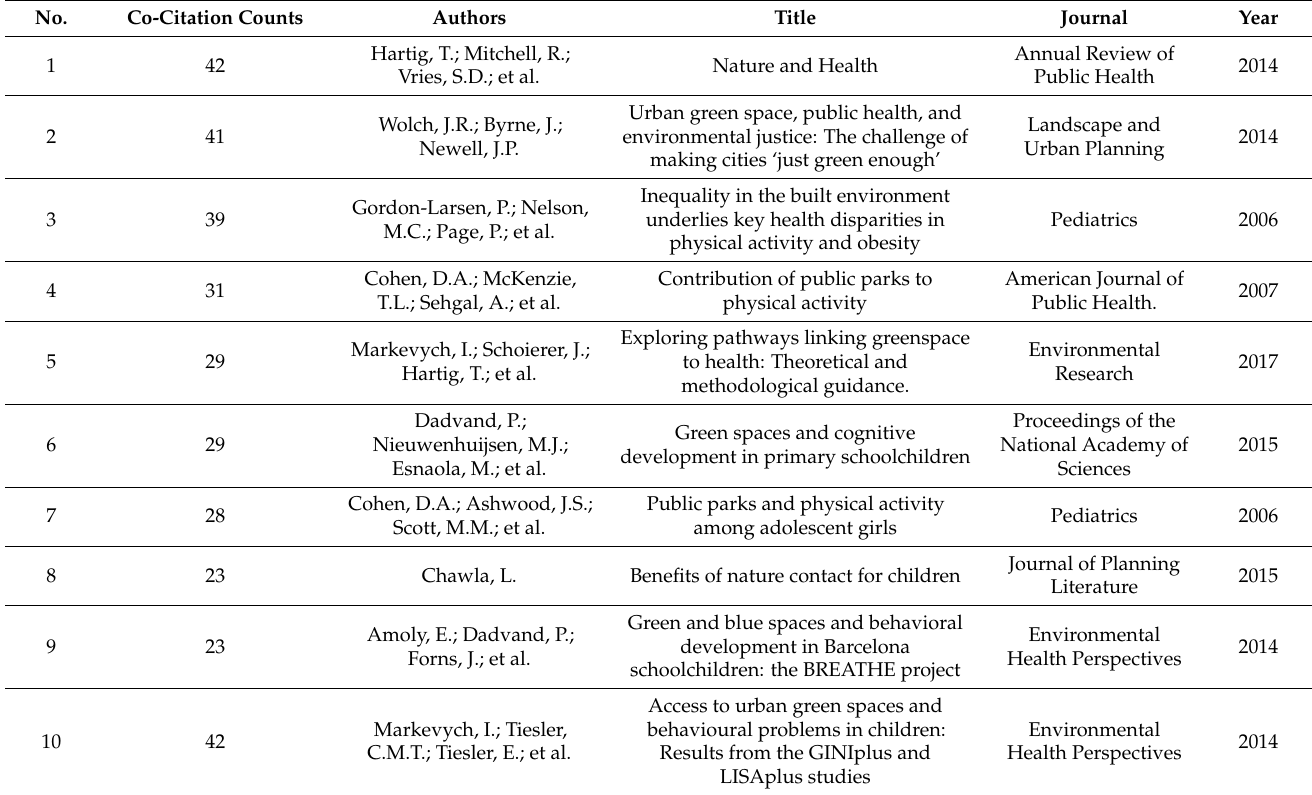
Table 1. The top-10 references with the most Co-citation counts.